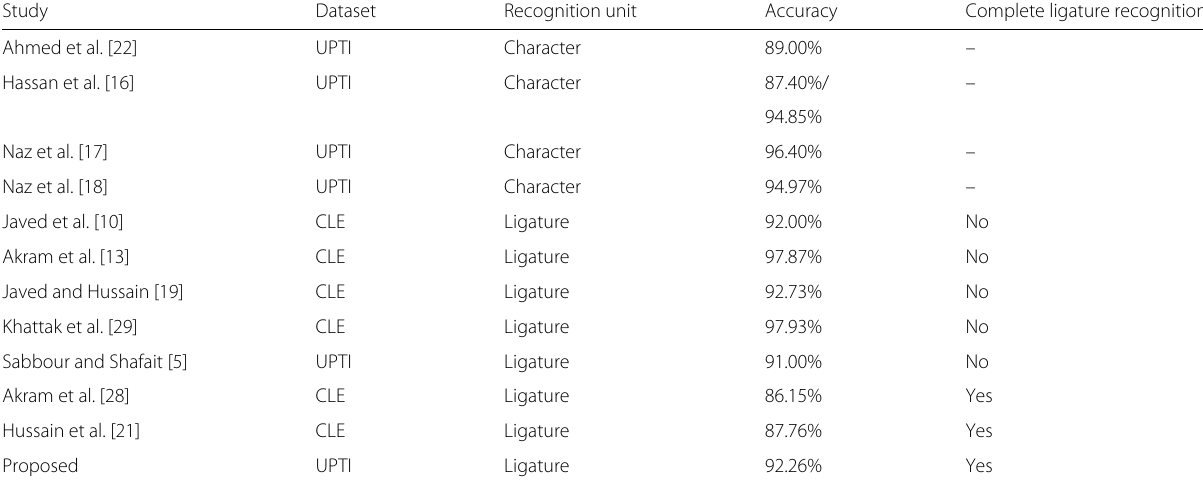
Table 10 Comparison of proposed method with notable